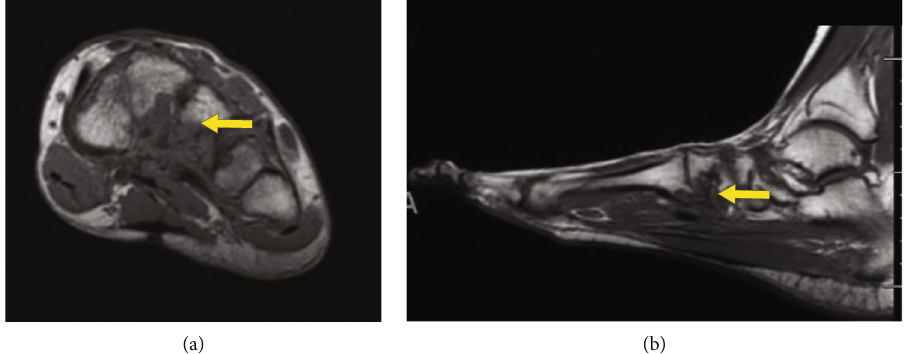
Figure 8: Coronal and sagittal images of a 35-year-old female with D-TGCT in the foot. (a) Coronal and (b) sagittal T1 weighted images demonstrating overall stable appearance of the hypointense T1 weighted images of the foot (arrow), consistent with known